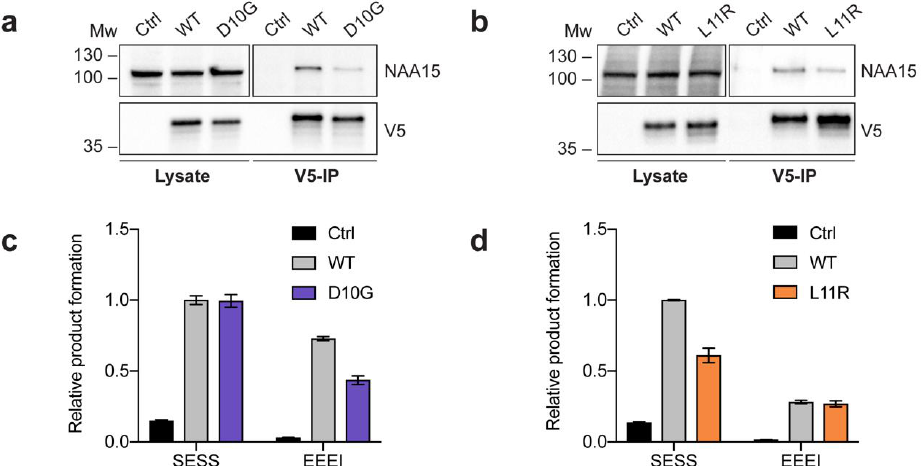
Figure 2. NAA10-V5 immunoprecipitation (IP) and in vitro N-terminal (Nt) acetylation assays. ( a , b ) Western blot analyses showing V5-IP of NAA10-WT-V5 and either NAA10-D10G-V5 ( a ) or NAA10-L11R-V5 ( b ). The immunoblots were probed with anti-V5 tag and anti-NAA15 antibodies. ( c , d ) The catalytic activity of the NAA10 variants, NAA10-D10G-V5 ( c ) and NAA10-L11R-V5 ( d ), was compared to NAA10-WT-V5 through in vitro Nt-acetylation assays. Negative controls included reactions without peptide and with β-gal-V5 IP. The measured activities towards the canonical NatA complex substrate SESS 24 and the in vitro monomeric NAA10 substrate EEEI 24 were normalised to the amount of NAA15 and NAA10-V5 used in the reaction, respectively. The Western blot analyses and Nt-acetylation assays shown are representative of three independent experiments. The Nt-acetylation assays were performed with three technical